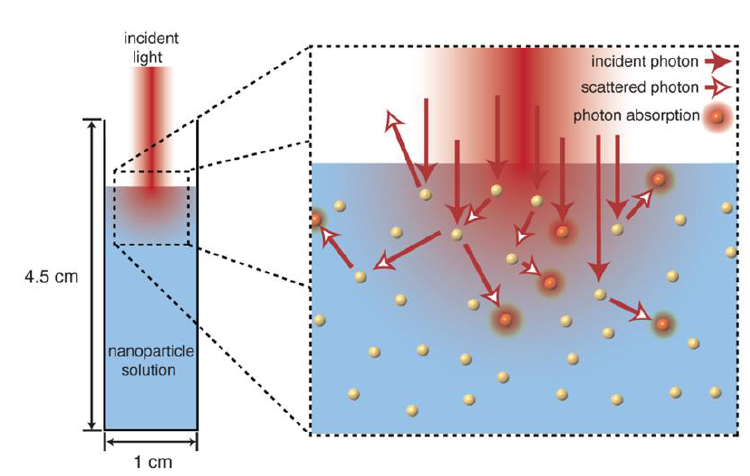
Figure 5. Schematic illustration of light scattering and absorption [46]; 2014, ACS.